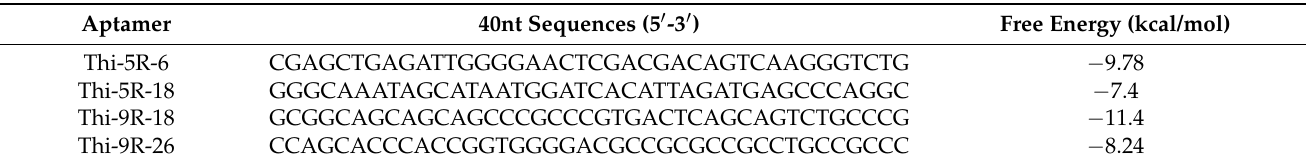
Figure 4. The secondary structures of aptamer candidates. Table 1. Sequences of aptamer candidates.